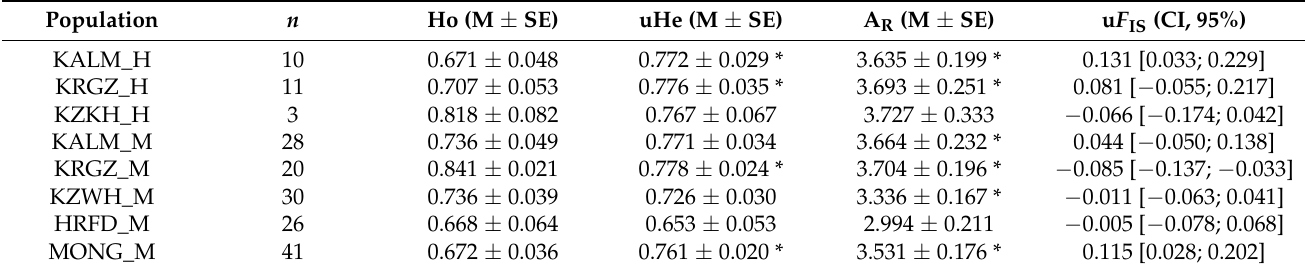
Table 3. Summary statistics for museum and modern populations of studied breeds based on genotypes of 11